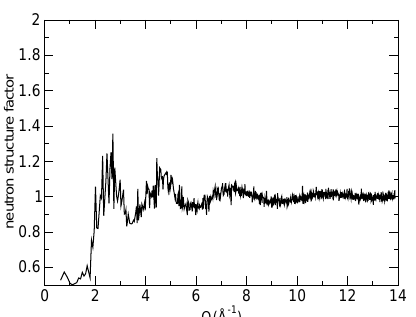
Fig. 6. Neutron structure factor for the liquid Si 3 N